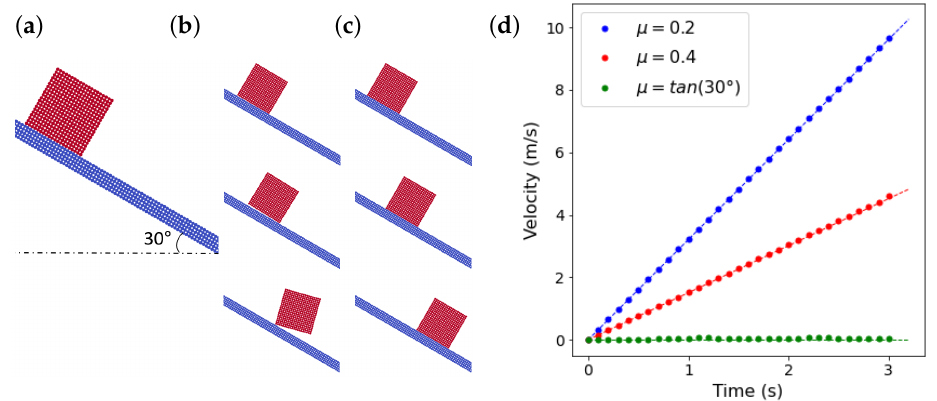
Figure 2. ( a ) The initial two-dimensional model where the slider (in red) is the primary solid body and ( b ) snapshots of a simulation where the contact model is only based on particle-particle penetration which leads to wrong solutions. ( c ) Snapshots of a simulation where the new contact model is employed. Both sets of snapshots are taken at 0.5s, 1.0s and 1.5s, from top to bottom. ( d ) The velocity of the slider parallel to the slope, dots represent the simulations results and dash-lines represent the analytical solutions of this